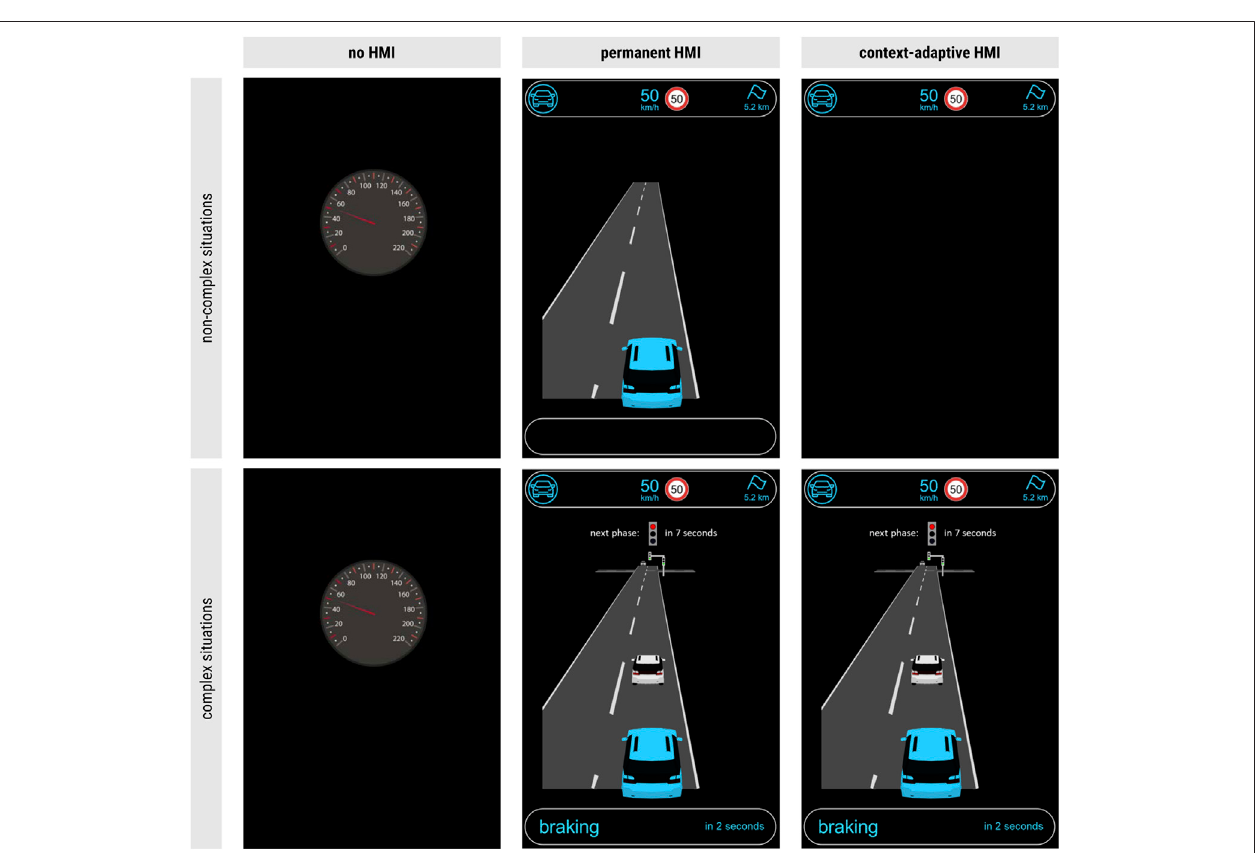
FIGURE1| InformationpresentedinthecenterstackdisplayofthevehicleduringthethreeHMIconditions. Note. Displayedtraf fi csituationsareexemplaryfornon- complex and complex situations along the test track. The cyan-colored vehicle represents the own automated vehicle.